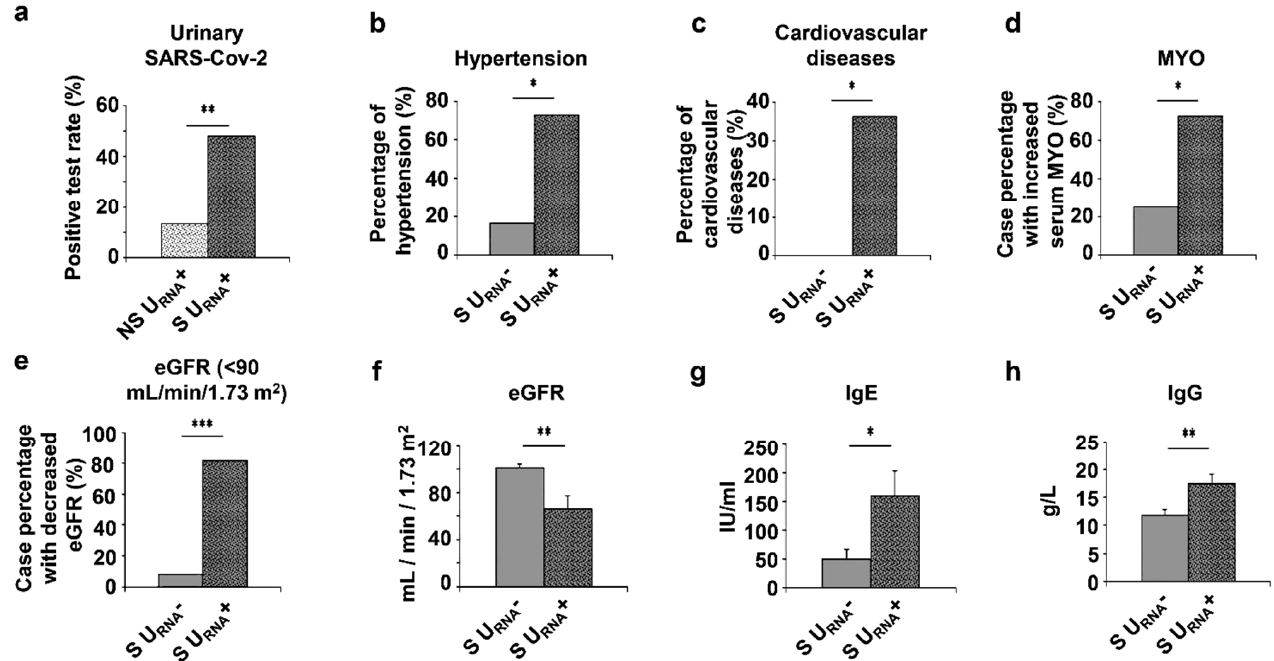
Figure 2. Categorical variable results of laboratory tests and comorbidities of COVID-19 patients on admission. ( a ) The positive test rate of urinary SARS-CoV-2 in non-severe (NS) U RNA + and S U RNA + patients. ( b , c ) The prevalence of hypertension and cardiovascular disease in Severe (S) U RNA − and Severe U RNA + patients. ( d , e ) The case percentage of increased serum MYO and decreased eGFR. in S U RNA − and S U RNA − patients. ( f – h ) The levels of eGFR, serum IgE and serum IgG in S U RNA − and S U RNA + patients. * p < 0.05, ** p < 0.01, *** p < 0.001.